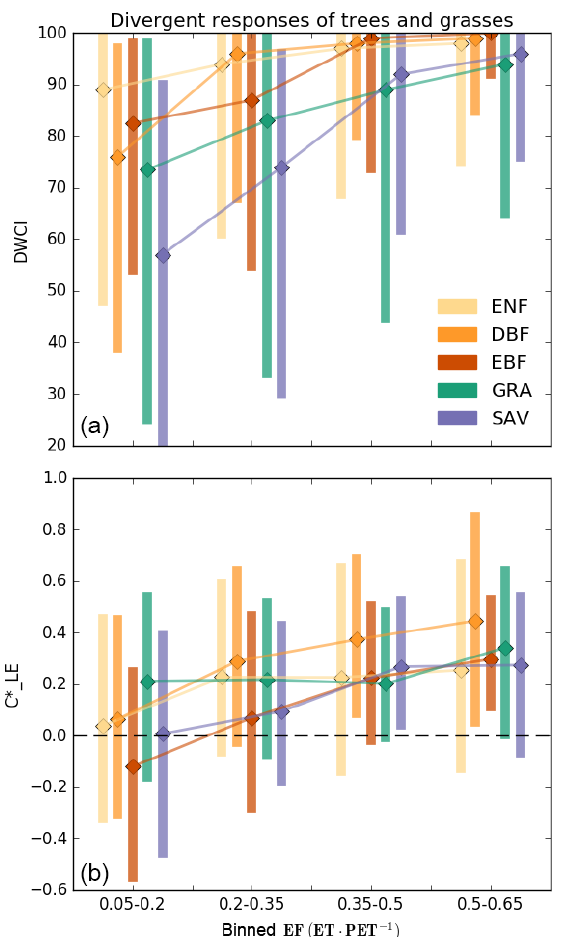
Figure 5. Median Diurnal Water–Carbon Index (DWCI, a ) and di- urnal centroid ( C ∗ , b ) of plant functional types binned by evapo- ET rative fraction (EF, low values indicate dry conditions). Note that DWCI of 0–100 indicates lowest–highest probability of diurnal carbon–water coupling and that C ∗ of − 1 to 1 indicates 1-hour ET morning-shifted to 1-hour afternoon-shifted ET. Evergreen needle- leaf (ENF), deciduous broadleaf (DBF), and evergreen broadleaf (EBF) forests show increased morning shifts (low C ∗ ) with de- ET creasing EF when compared to grassland (GRA) sites, which tended to have decreased carbon–water decoupling (low DWCI) with de- creasing EF. Savanna ecosystems (SAV) show a high degree of de- coupling and intermediate levels of morning shifts. Vertical bars represent the interquartile